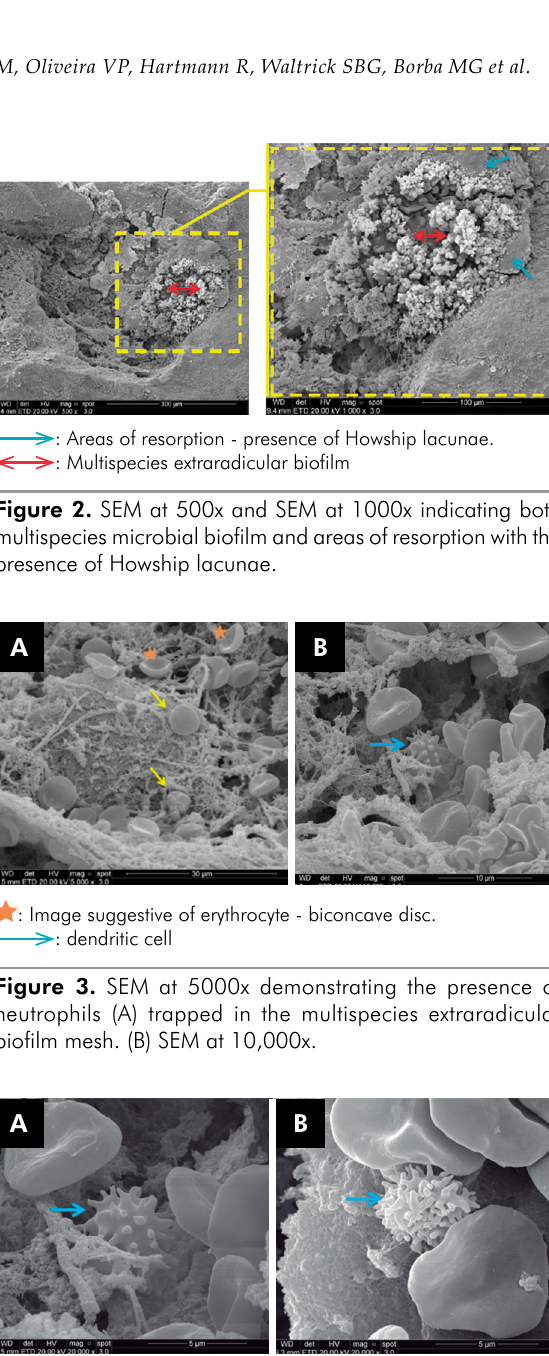
Figure 4. (A) SEM at 20,000x. (B) Image suggestive of a second dendritic cell in the same apex (20,000x).